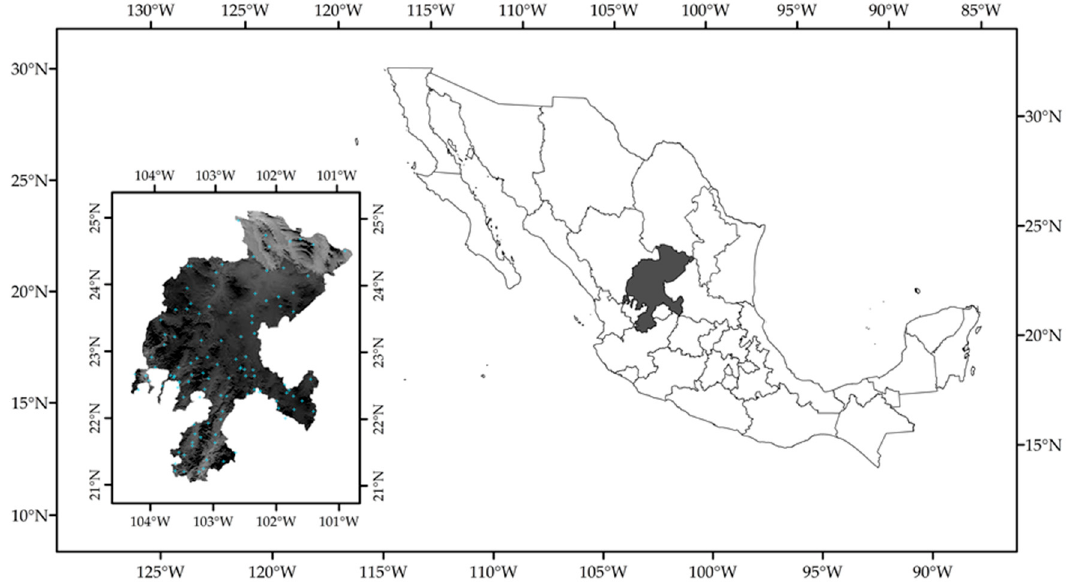
Figure 1. Geographical location of Zacatecas, Mexico. Blue dots represent weather stations.